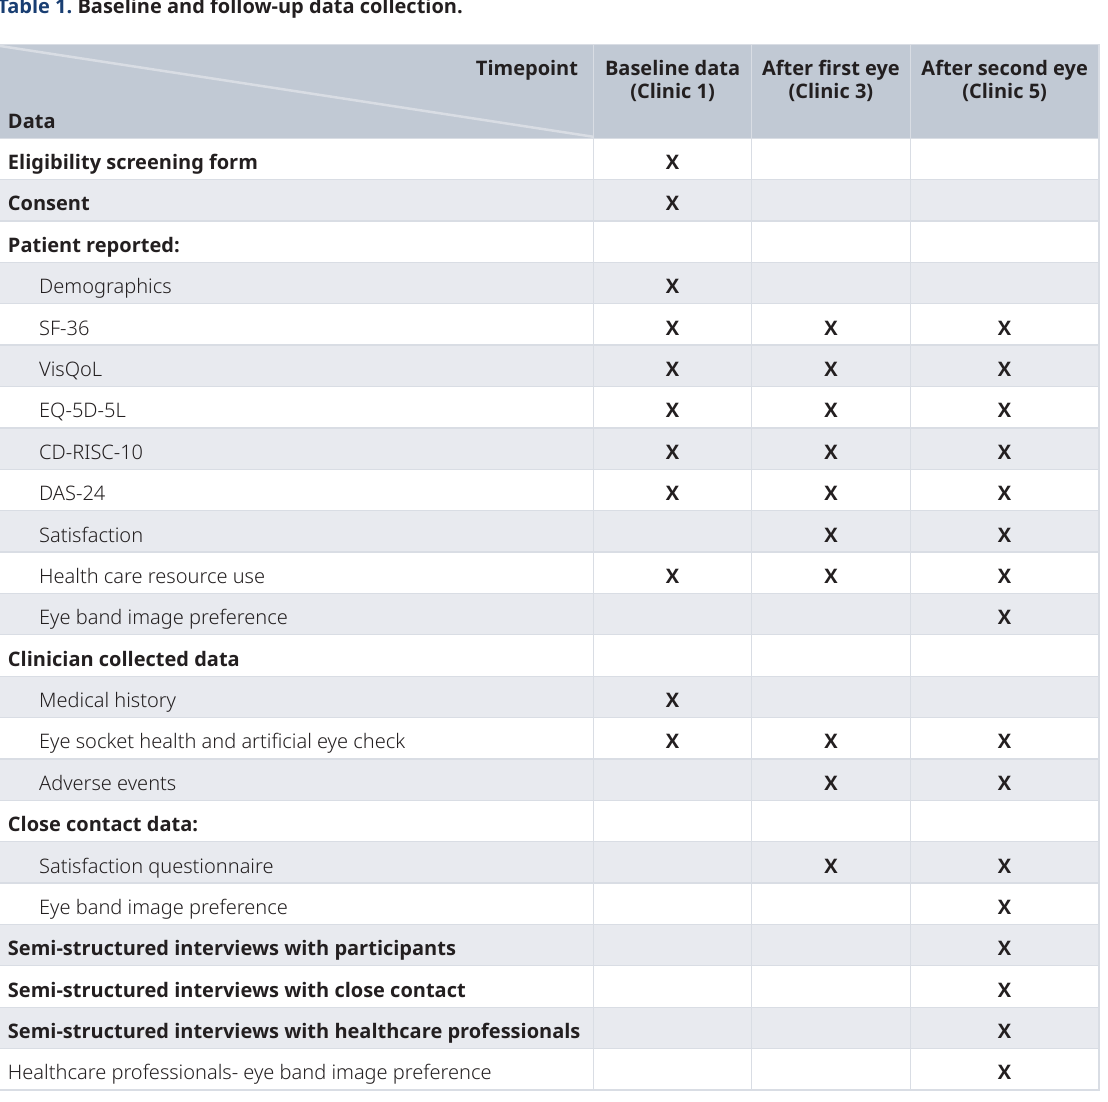
Table 1. Baseline and follow-up data